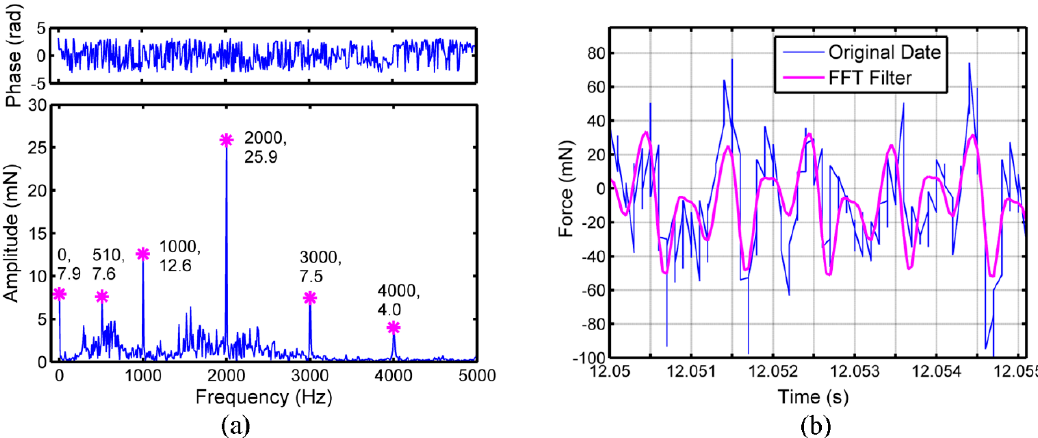
Figure 4. The cutting force signals of cross feed direction ( F y ): ( a ) FFT analysis on cross feed force, ( b ) comparative curves between original data and data after FFT filtering.